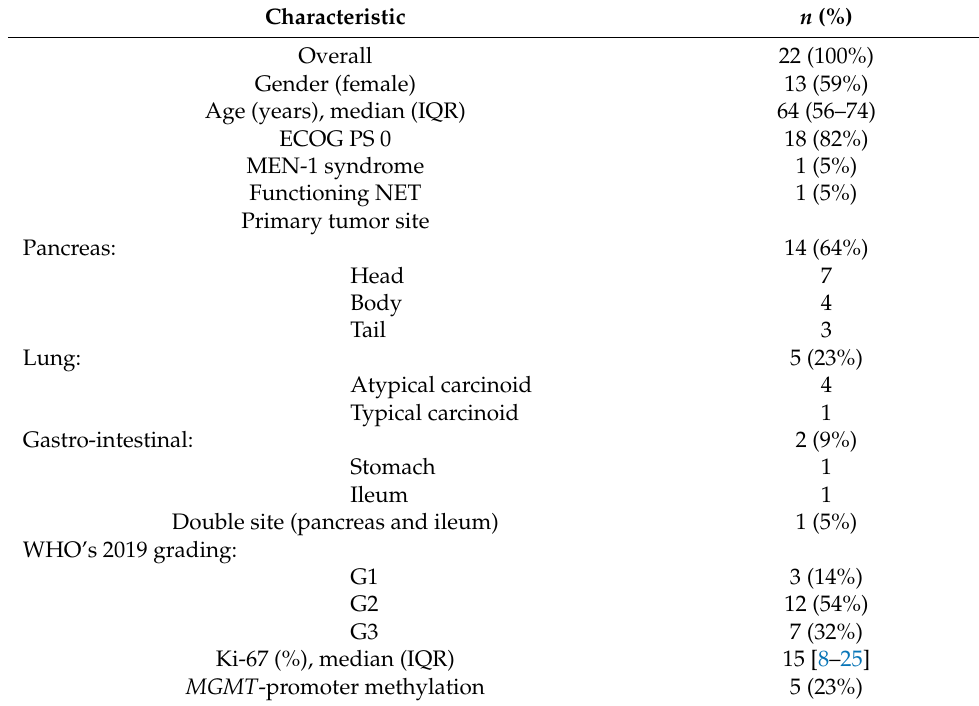
Table 1. Patients’ characteristics.